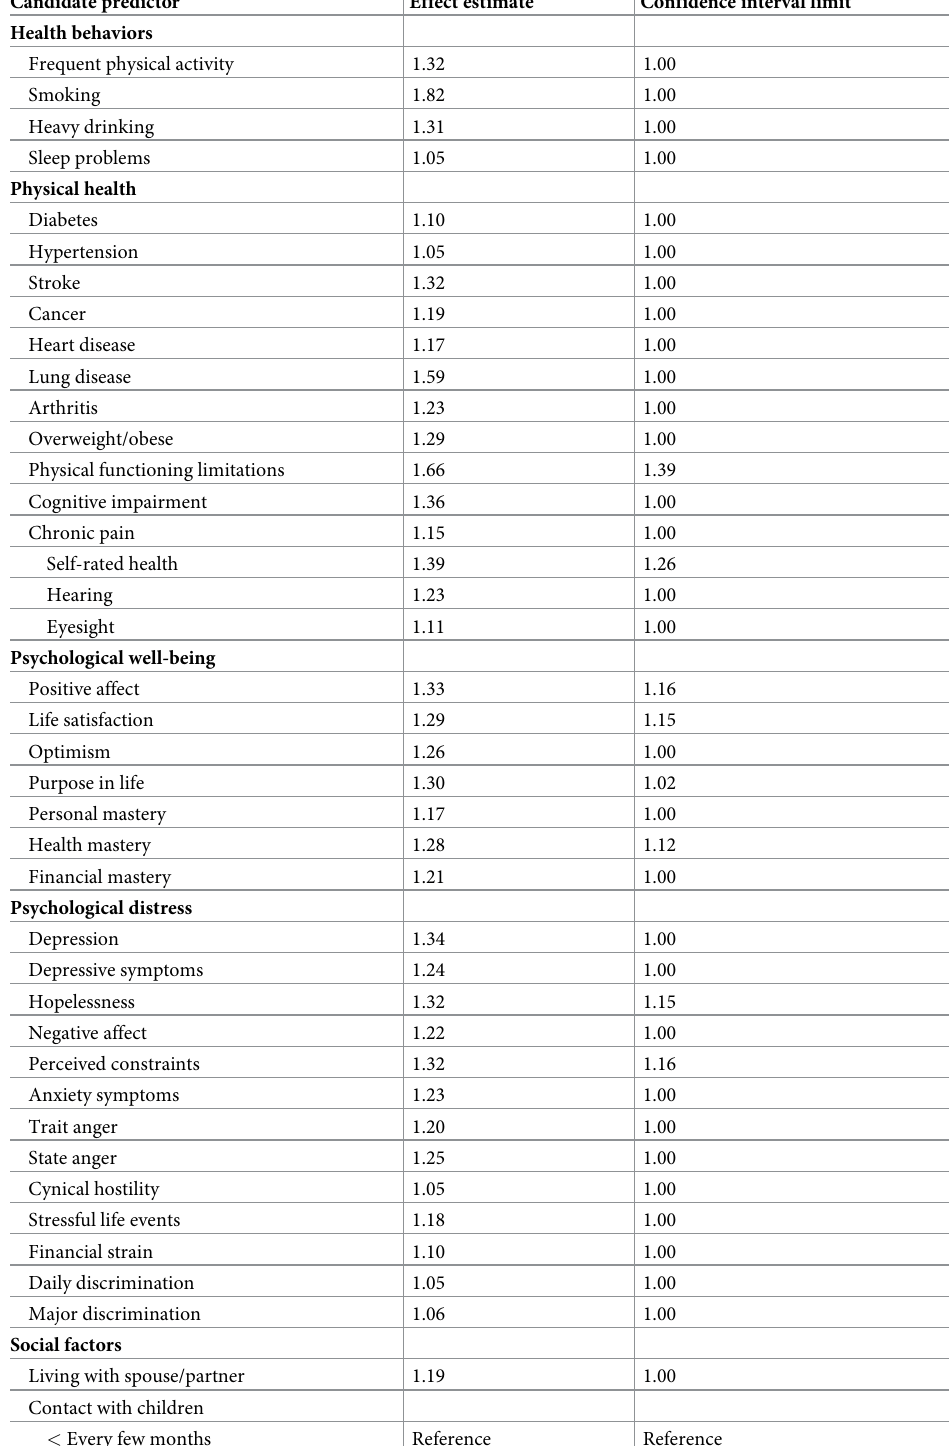
Table 3. Robustness to unmeasured confounding ( E -values) for the associations between candidate predictors (T 1 ) and subsequent religious service attendance (T 2 ) a,b,c